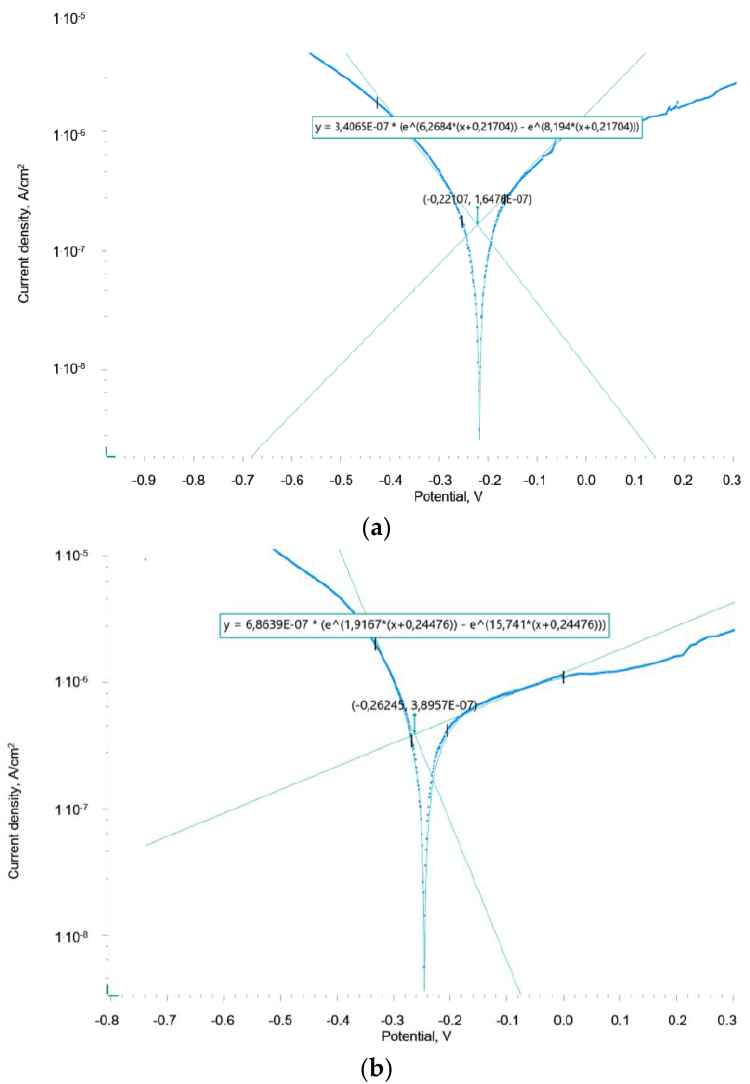
Figure 7. Polarization curves of the electrode made of Ti-6Al-4V titanium alloy (a) with the Zr-ZrN coating and (b) without coating in the 3 wt.% solution of NaCl: points—experimental data, straight lines—extrapolation of Tafel sections, curved line—results of mathematical modeling by the iteration method. Table 5. Results of mathematical modeling of the corrosion process on the samples of Ti-6Al-4V alloy with different coatings in the 3 wt.% aqueous solution of NaCl at the temperature of 25 °C, by the method of Tafel extrapolation of the anodic and cathodic polarization curves.